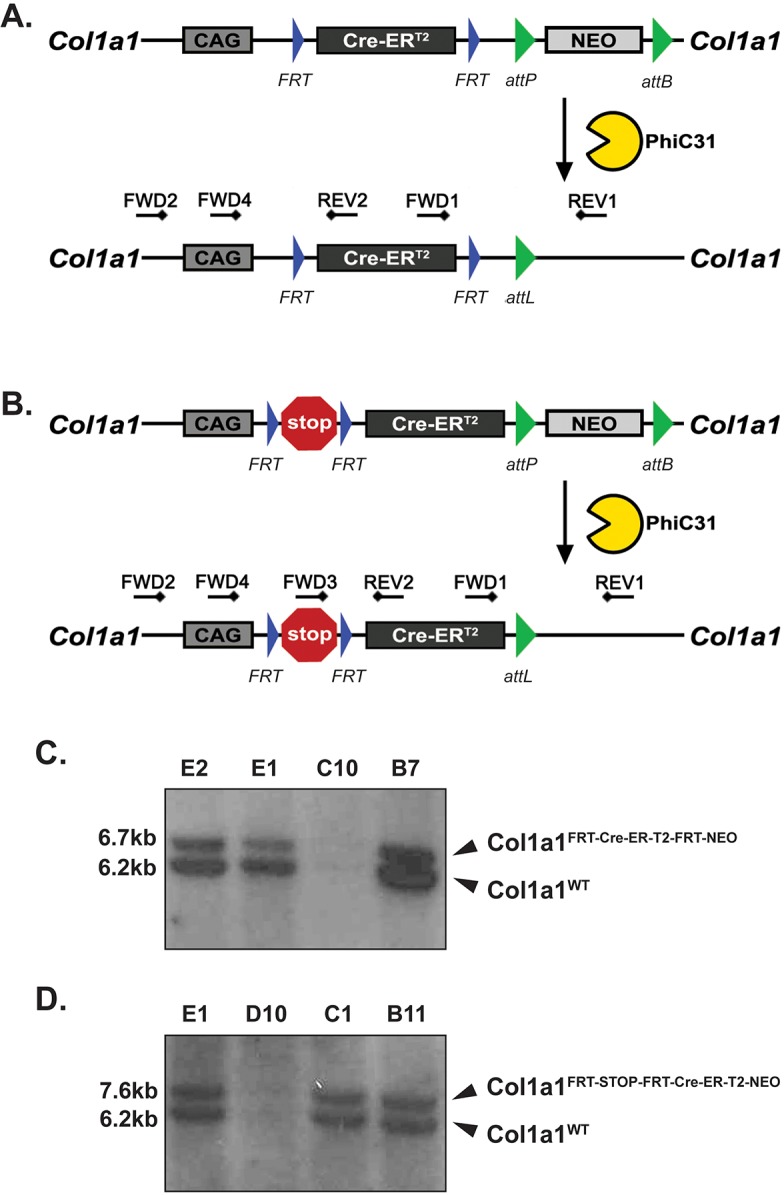
Schematics for Col1a1-directed expression of FRT-Cre-ERT2-FRT and FRT-STOP-FRT-Cre-ERT2, the removal of the neomycin selection cassette, and Southern blot for successful homologous recombination. Schematic of the Col1a1FRT-Cre-ER-T2-FRT (A) and Col1a1FRT-STOP-FRT-Cre-ER-T2 (B) alleles. The neomycin cassette is used for selection of ES cells with integration of the targeting construct. PhiC31 integrase is used to remove the neomycin selection cassette in vivo after germline transmission. Locations of genotyping primers are indicated on each schematic. (C) Southern blot analysis indicates successful homologous recombination of the Col1a1FRT-Cre-ER-T2-FRT-NEO allele in the E2, E1 and B7 clones. The B7 clone was used to generate the Col1a1FRT-Cre-ER-T2-FRT-NEO line. (D) Southern blot analysis indicates successful homologous recombination of the Col1a1FRT-STOP-FRT-Cre-ER-T2-NEO allele in the E1, C1 and B11 clones. The B11 clone was used to generate the Col1a1FRT-STOP-FRT-Cre-ER-T2-NEO line.